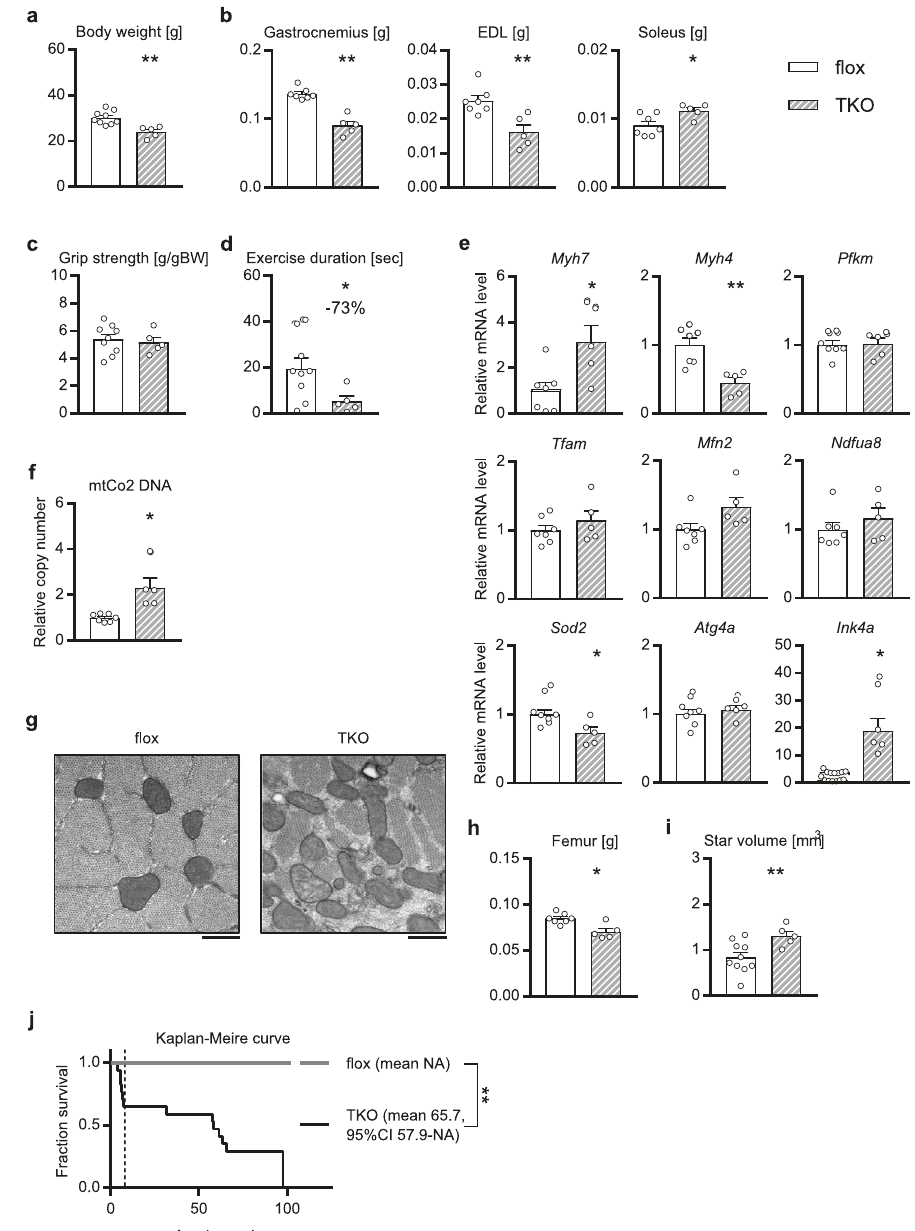
Fig.8|PhenotypesofthemAkt/TscTKOmice.a Bodyweight( n =5or9miceper group, as shown by the number of data points on the graph, same as below), b , h tissue weight ( n =5 or 7 mice), c grip strength ( n =5 or 9 mice), and d exercise duration( n =5or9mice),ofthe mAkt/TscTKOmiceattheageof 52weeks. e Gene expression, and f DNAcopynumber,of EDLatthe age of 52weeks analyzedbyRT- PCR( n =5or 7mice). g Electronmicroscopicimage of verticalsectioning of